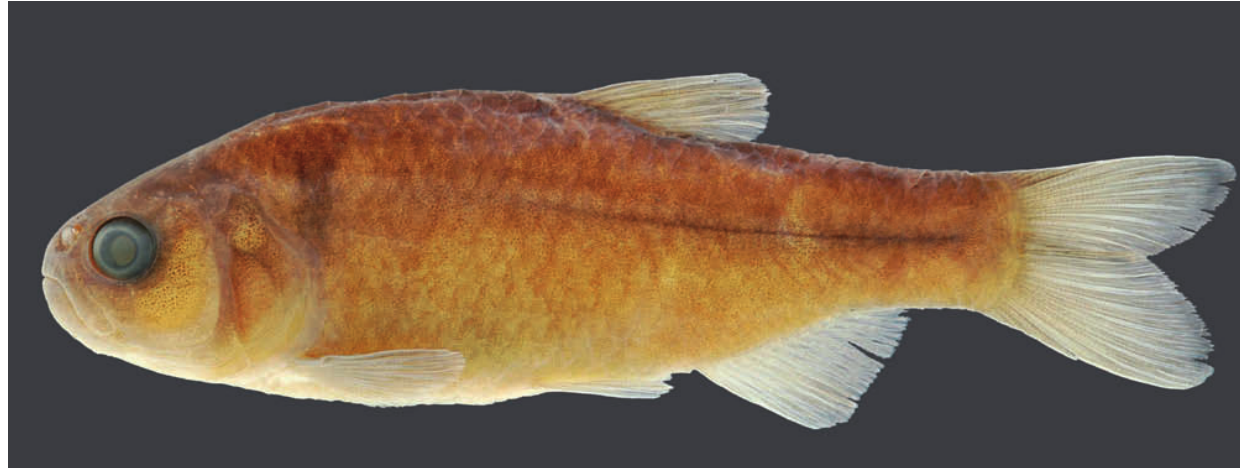
Fig. 1. Hasemania piatan , holotype, MZUSP 104538, 54.0 mm SL; Brazil, Bahia, Piatã, riacho Três Morros, tributary of rio de Contas